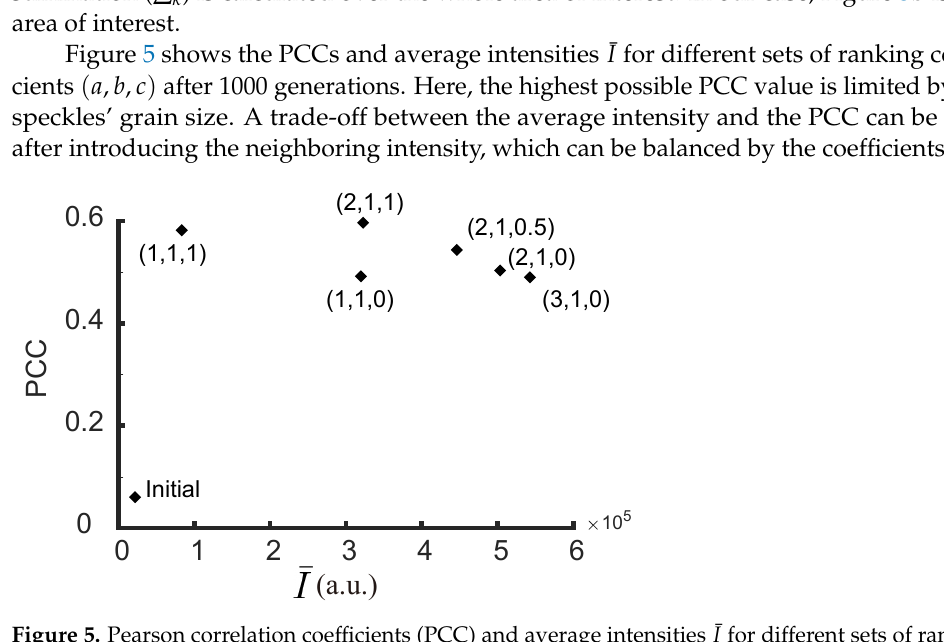
Figure 5. Pearson correlation coefficients (PCC) and average intensities ¯ I for different sets of ranking coefficients ( a , b , c ) after 1000 generations. The ranking coefficients are labeled near the points. The initial point is also shown in the bottom left corner.